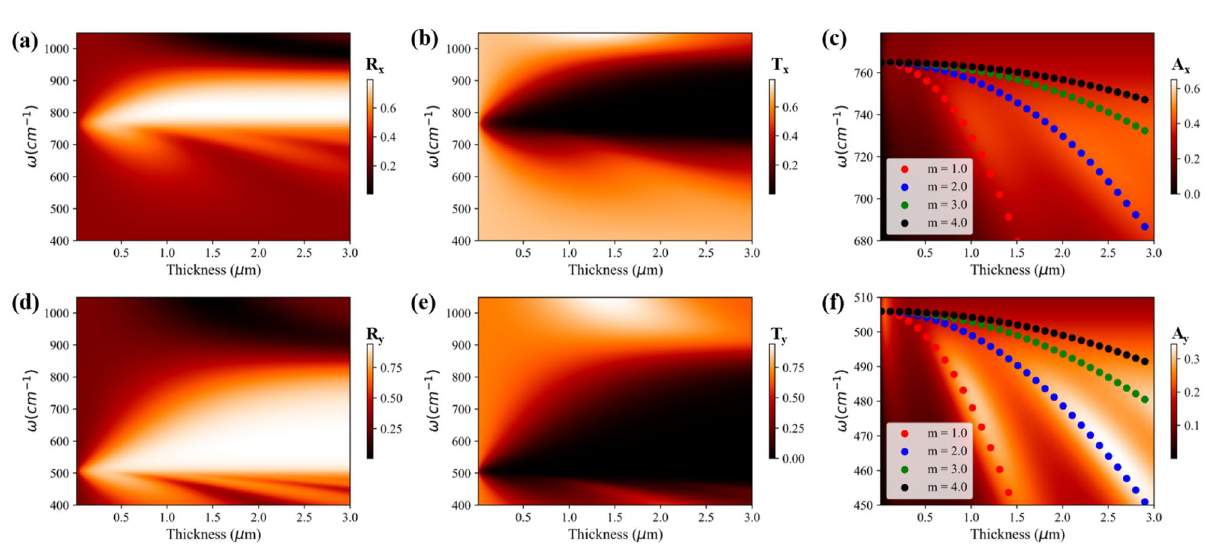
Figure 3. ( a – c ) correspond to the reflectance, transmittance, and absorbance, respectively, of α - V 2 O 5 for x -polarized incident light as a function of thickness and frequency. ( d – f ) represent the reflectance, transmittance, and absorbance, respectively, of α - V 2 O 5 for y -polarized incident light as a function of thickness and frequency. The scatter plots in absorption color plots correspond to Fabry Perot modes of α - V 2 O 5 thin